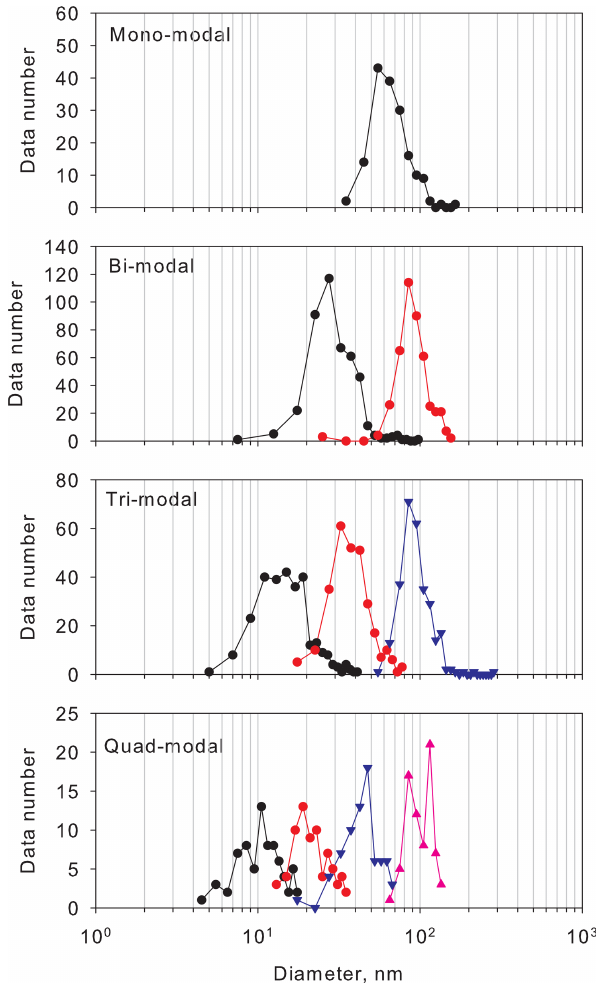
Figure 3. Histogram of modal sizes in each modal structure. Sym- bols and lines of black, red, blue, and magenta show histograms of the first, second, third, and fourth modes in each modal structure.